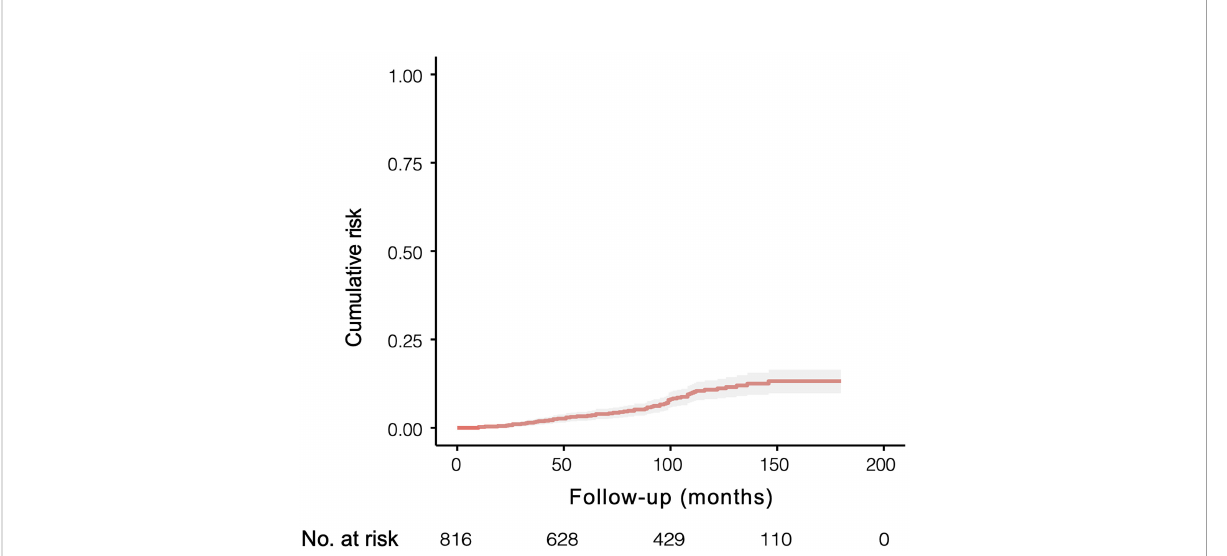
FIGURE 2 Cumulative risk of being diagnosed as ABP in 816 individuals with symptomatic gallstones and followed for a median of 89 months [IQR 45.8- 130.0